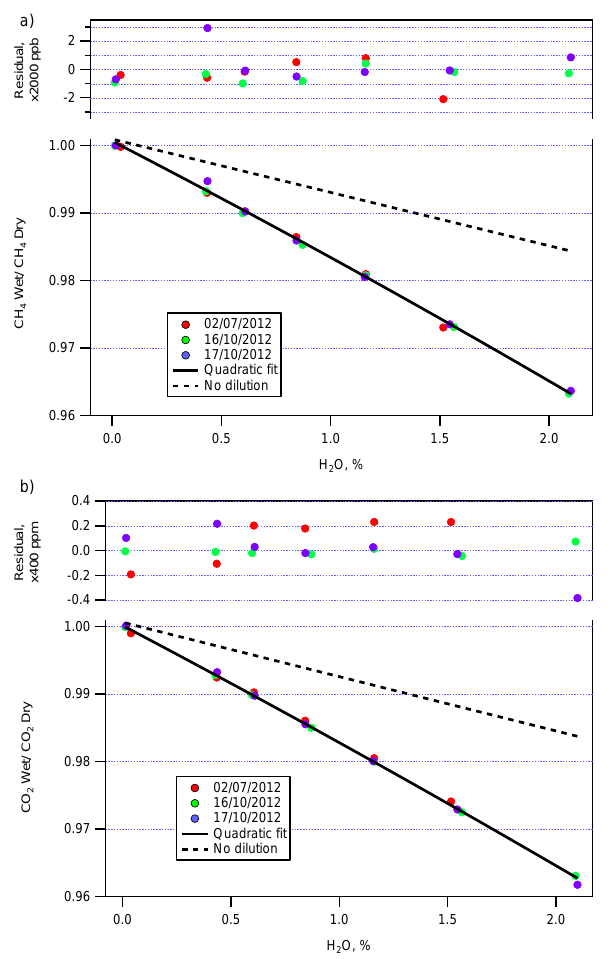
Fig. 5. The FGGA’s response to varying humidity was determined by humidifying air from a cylinder. The dry measurements were de- termined by passing the humidified air through a dry-ice trap before it was analysed. This test was repeated three times over a three- month period to test the repeatability of the system. A relationship between the dry-air mole fraction and the measured wet-air mole fraction was determined using a quadratic fit to (a) CH 4 wet/CH 4 dry versus H 2 O and (b) CO 2 wet/CO 2 dry versus H 2 O. The dashed lines have been determined by applying Eq. (2) to CH 4 wet and CO 2 wet, this suggests that only correcting for the dilution effect due to H 2 O is not sufficient to determine dry-air mole fractions.